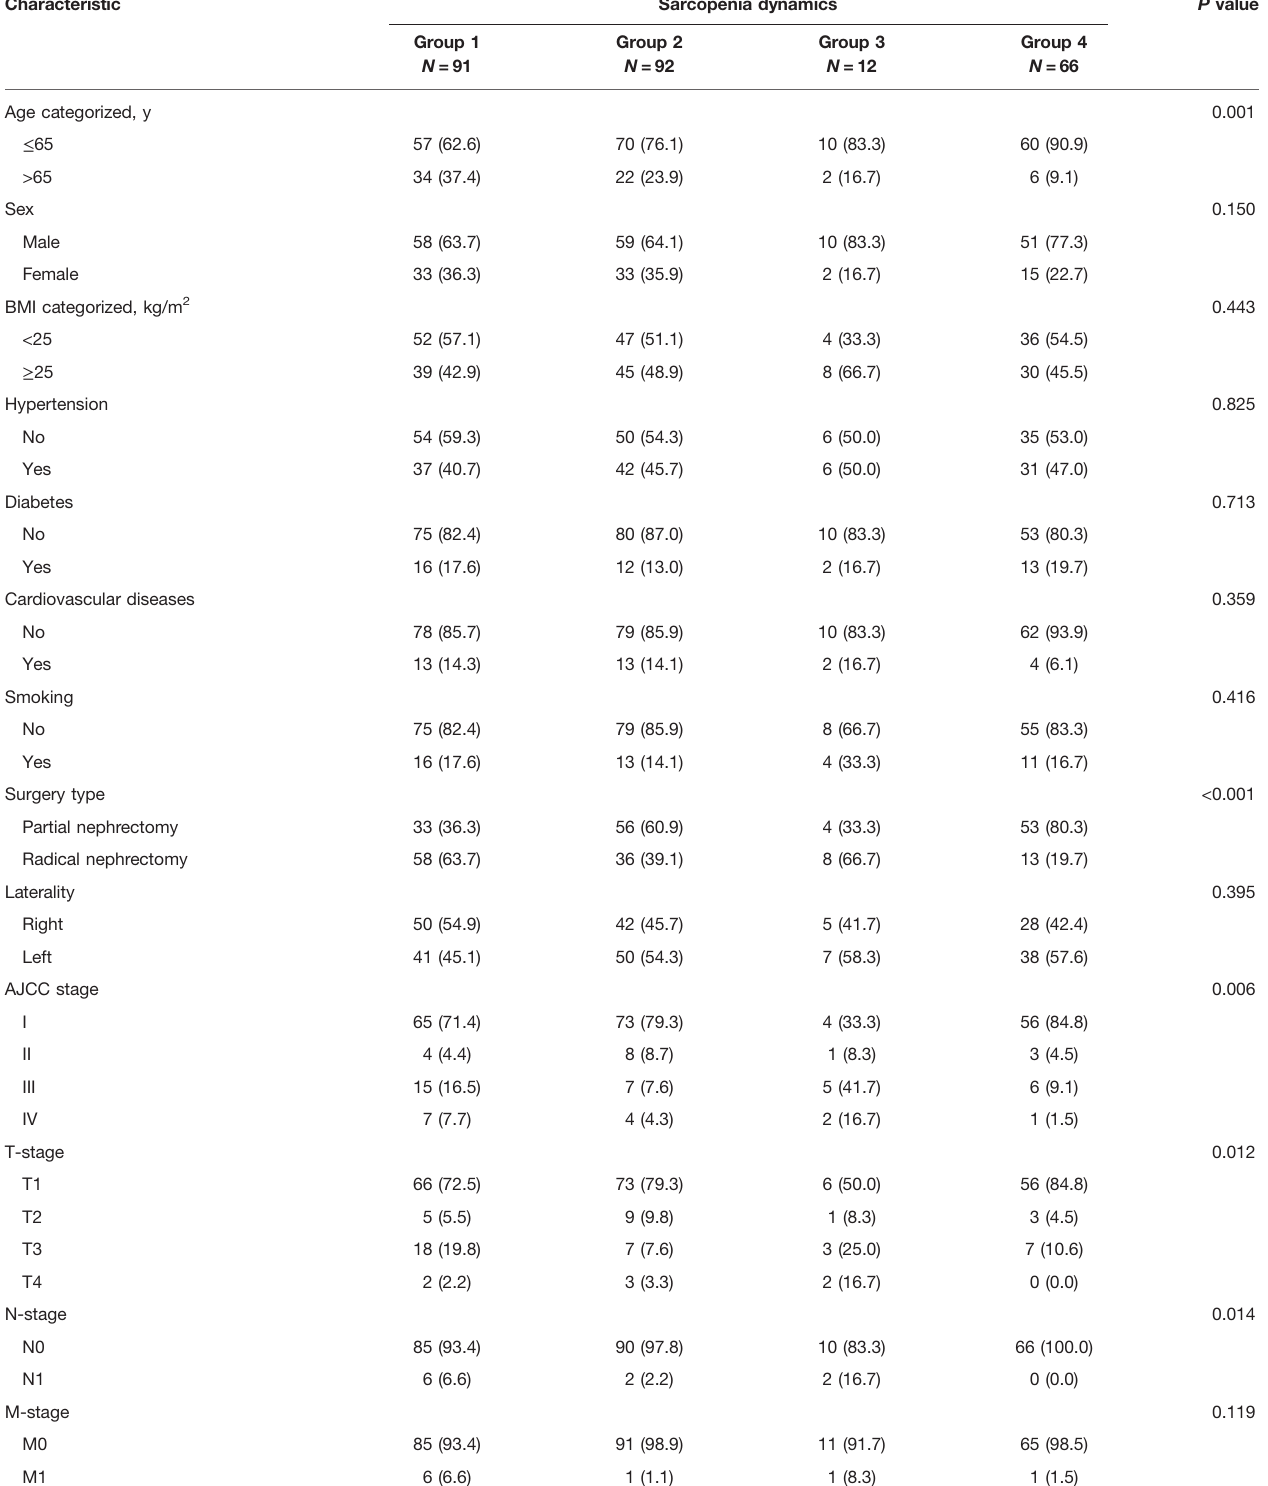
TABLE 2 | Baseline characteristics of the patients according to sarcopenia